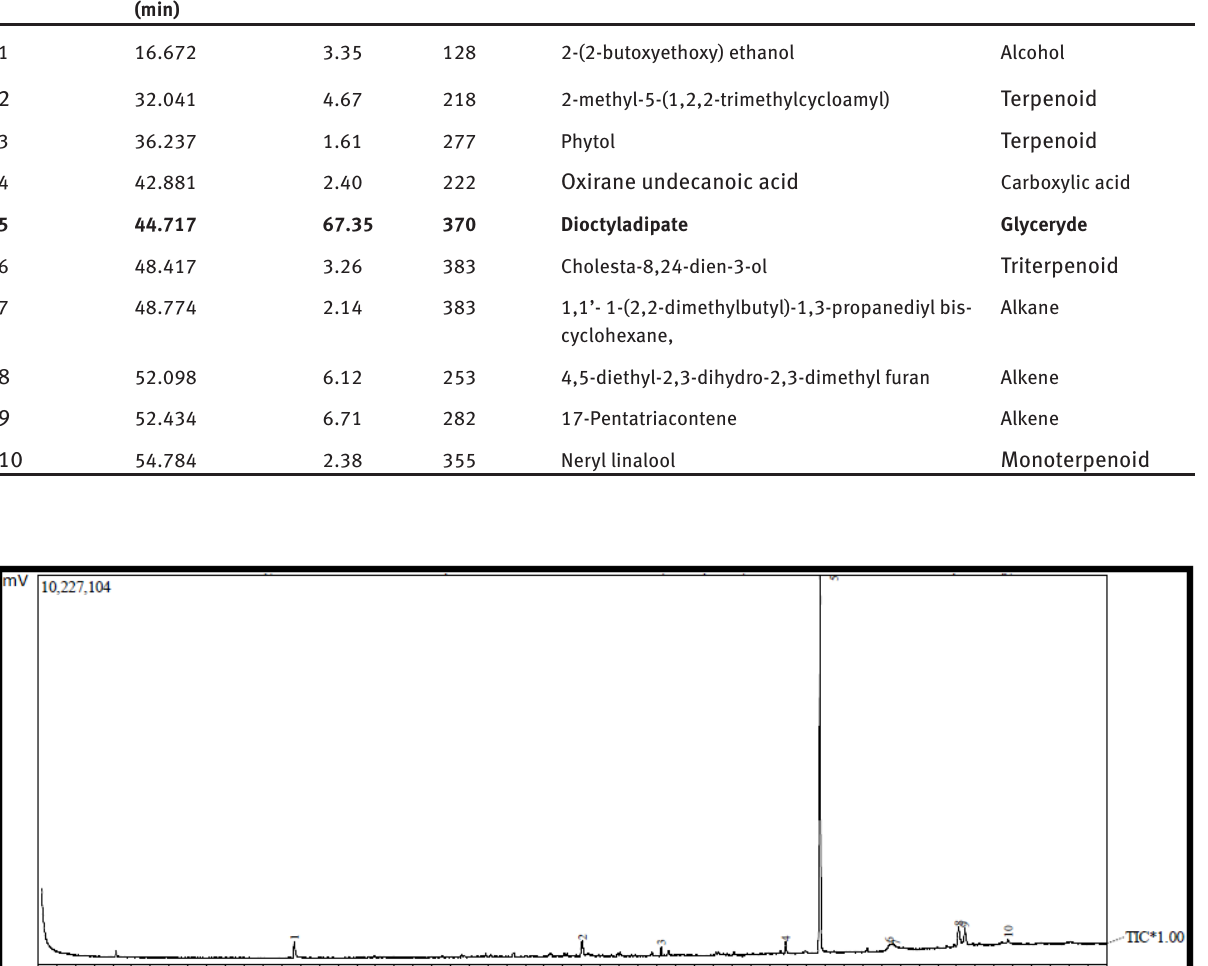
Table 2: Result of analysis of dioctyladipate based on similarity index on GC-MS. Peak